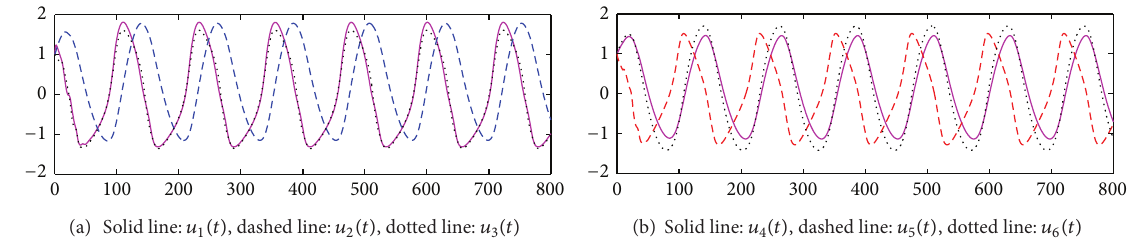
(a) Solid line: 𝑢 1 (𝑡) , dashed line: 𝑢 2 (𝑡) , dotted line: 𝑢 3 (𝑡) (b) Solid line: 𝑢 4 (𝑡) , dashed line: 𝑢 5 (𝑡) , dotted line: 𝑢 6 (𝑡) Figure 4: Periodic oscillatory behavior, activation function: tanh (𝑢) , and delays: (9, 10,